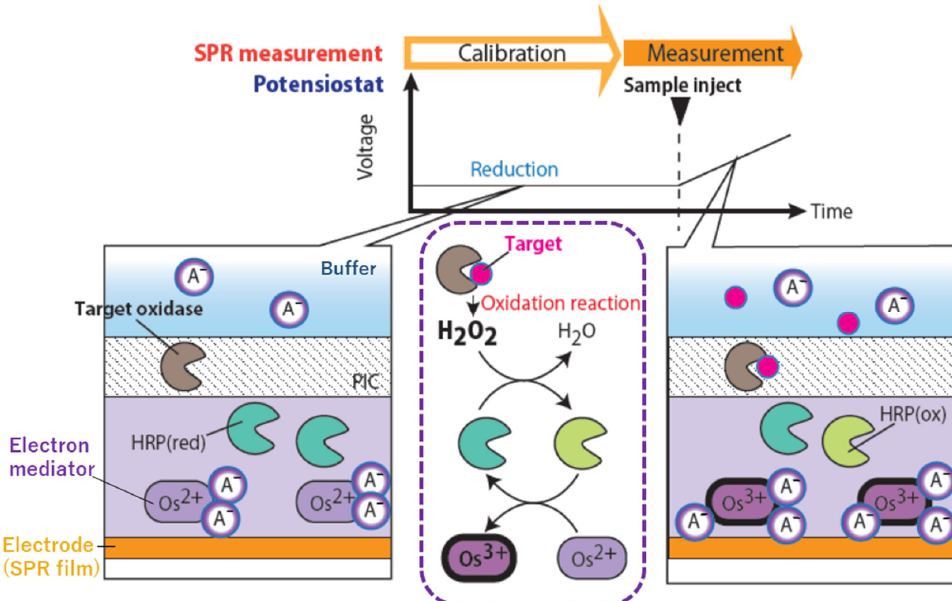
Figure 1. Mechanism of EC-SPR measurement. A- is a charge compensation molecule in a buffer consisting of chlorine ions and phosphate ions. The illustration enclosed in the purple dotted line is the molecular electronic transition reaction cascade from target capture to electron mediator oxidization. Reduced electron mediators attract two charge compensation molecules per molecule, but when oxidases capture the target molecule, the charge of the electron mediator changes, attracting three charge compensation molecules per molecule. Since SPR can detect the molecular concentration on the electrode surface, it can detect the difference in the charge compensation molecular weight attracted by the electron mediator.